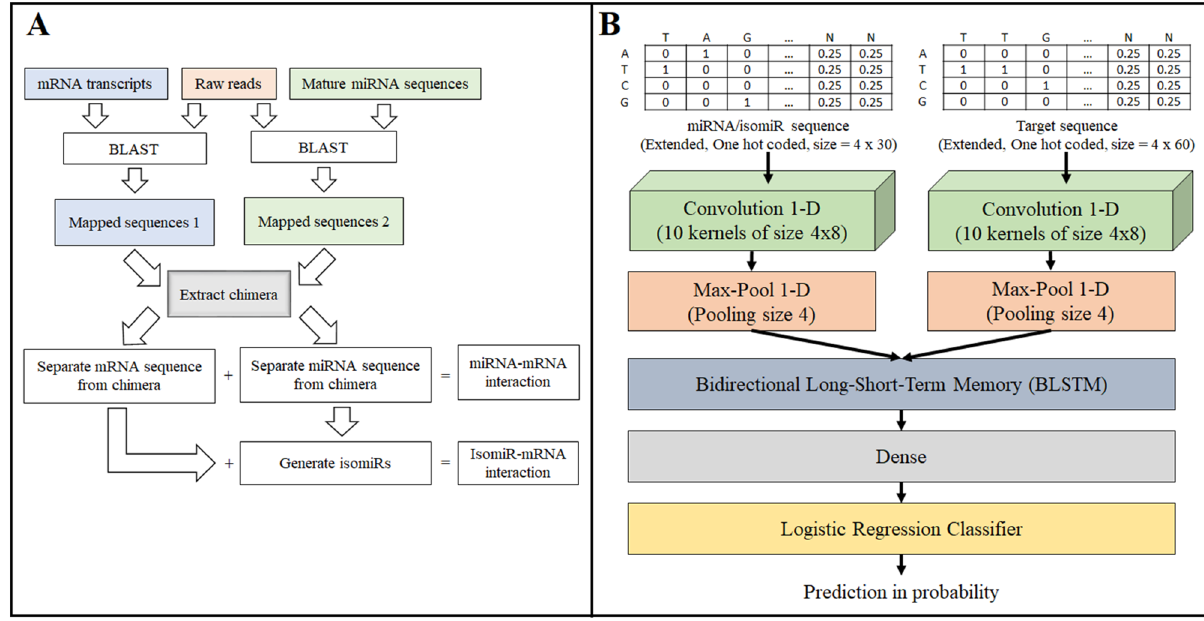
Figure 1. ( A ) The pipeline to obtain miRNA/isomiR–mRNA interactions. ( B ) The DMISO model